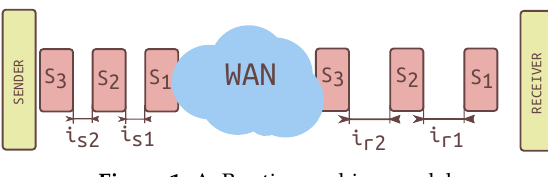
Figure 1. AvB active probing